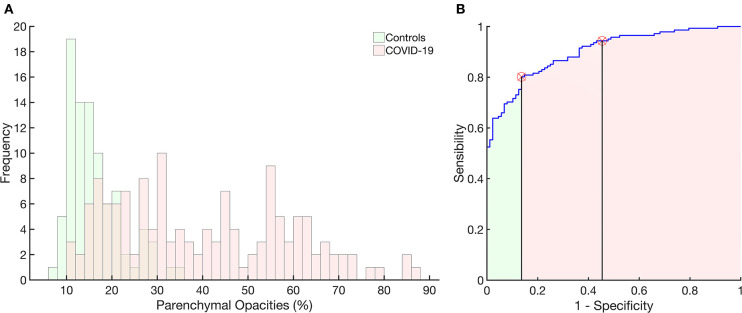
Histograms of the frequency of occurrence of parenchymal opacities in the control group (light green) and in patients with COVID-19 (pink). Right panel: receiver operator characteristic curve with the area under the curve (AUC) hatched in light green and pink. The vertical lines mark the normality cutoff (equivalent to 21% of total lung volume represented by pulmonary opacities) and the Z score = 3 (equivalent to 33% of the total lung volume and used to classify SSc patients as with severe pulmonary involvement). Between the normality cutoff up to Z score < 3, COVID-19 patients were classified as with moderate pulmonary involvement. The use of parenchymal opacities as an indicator of pulmonary involvement presented 0.80 sensitivity, 0.86 specificity, with an AUC of 0.90, accuracy of 0.82, 0.90 positive predictive value and 0.73 negative predictive value, F score of 0.85, and Matthews correlation coefficient of 0.65.